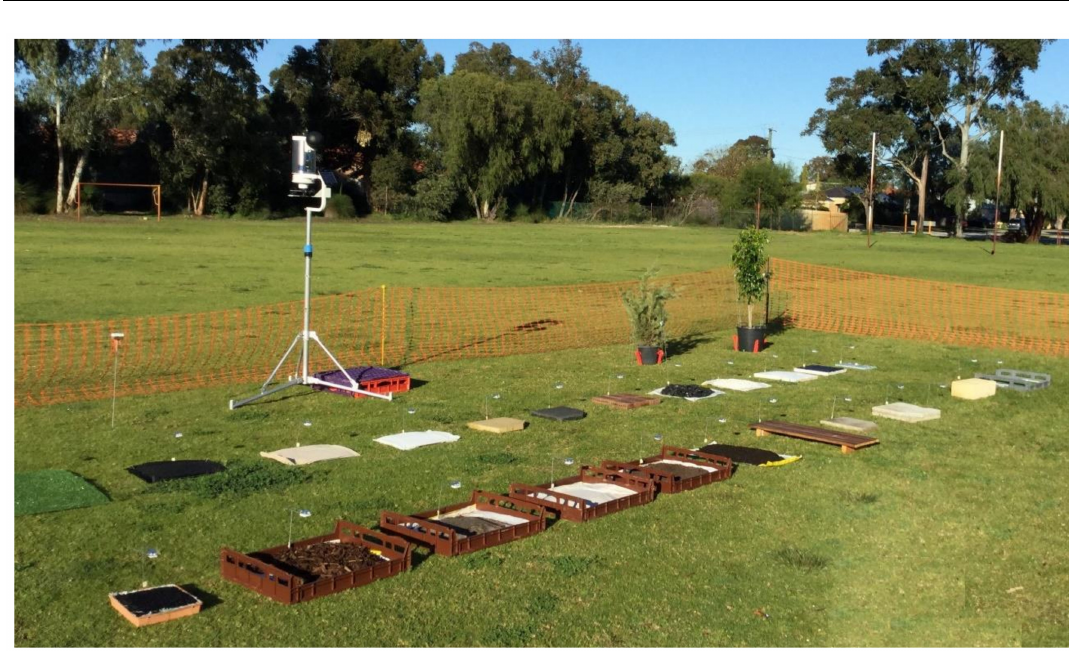
Figure 2. Phase 1 LEs showing the low-sided plastic crates and the polypropylene bags used to contain some